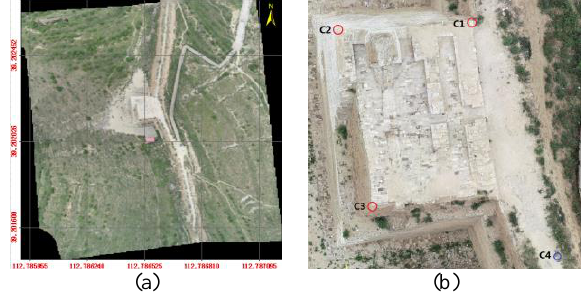
Figure 3. (a) The study area; (b) the distribution of collected points by RTK